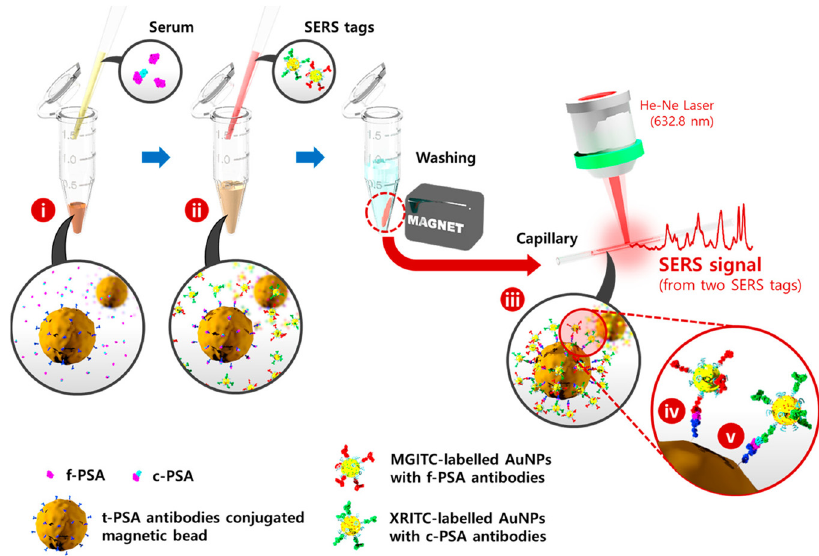
Figure 6. SERS-based assay for the simultaneous detection of f-PSA and c-PSA. MGITC and XRITC are the Raman reporter molecules. MGITC: malachite green isothiocyanate. XRITC: X-rhodamine-5-(and-6)-isothiocyanate. Reproduced with permission from [73]. Copyright 2017, American Chemical Society.